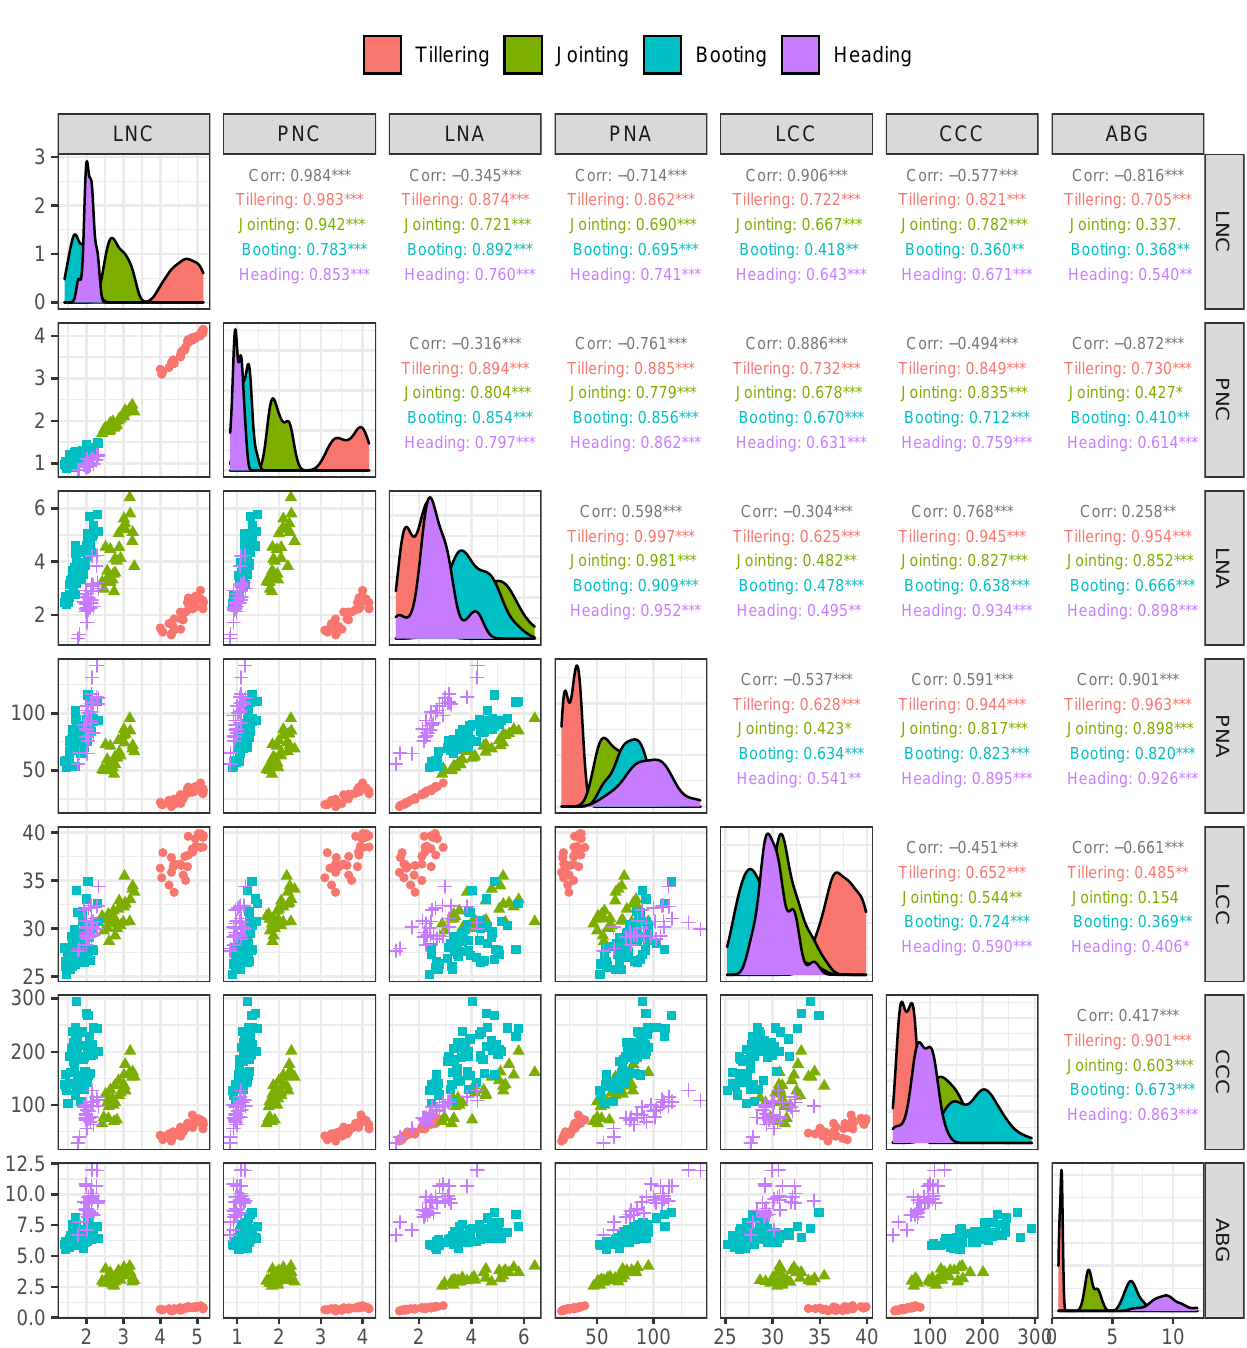
Figure 3. Pairwise scatter plots and correlations of the observed LNC, PNC, LNA, PNA, LCC, CCC and ABG. The diagonal is the growth-stage-specific density plots of the corresponding traits. The left bottom is pairwise scatter plots. The upper right panel shows the pairwise full data set and growth-stage-specific correlation coefficients. *** stands for significance at the 0.001 level, ** stands for significance at the 0.01 level, and * stands for significance at the 0.05